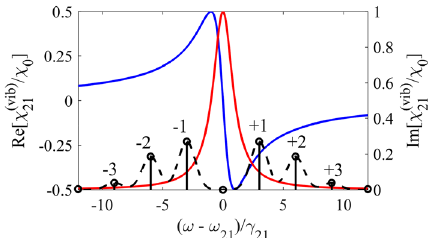
Figure 3. In the vibrating reference frame, real (blue curve, left axis) and imaginary (red curve, right axis) parts of the resonant susceptibility Eq. (23) of the motionless absorber as well as the power spectral density of the ω 21 , relatively broadened, � G γ 21 , incident wave packet with Gaussian spectral profile Eq. (36) resonant, ω 0 = = 3 and p 2.4 . The vertical black bars represent Fourier constituents γ 21 p 1 (black dashed line) under � = = = ω 0 n � . In the case of a narrowband incident wave packet, with maximum amplitude at the frequencies ω n = + (cid:31) the vertical black bars can be attributed to the discrete spectral components of the frequency-modulated